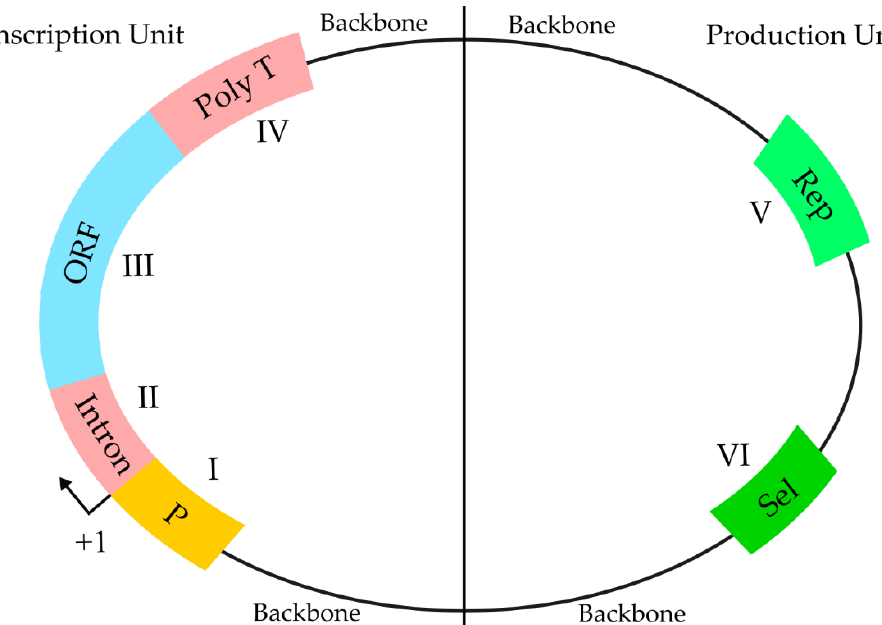
Figure 4. Schematic design of a plasmid DNA to be used in DNA vaccines. The transcription unit (on the left) contains several regions which includes a eukaryotic RNA polymerase II promoter (I), an intron (II) an antigen coding sequence (III) and a poly T region (IV) to produce a poly A tail in the transcript which can ease the export from the nucleus, stabilize the transcript and help in the translation process. The production unit (on the right) consists of a replication origin (V) for successful replication in the bacterial host and an antibiotic selection marker (VI).